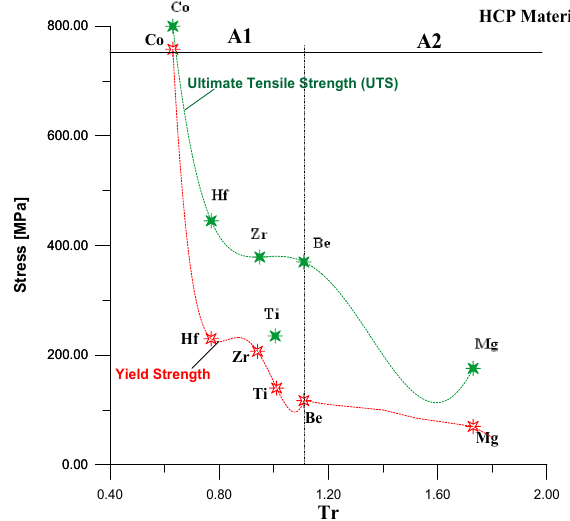
Figure 3. Relationship between yield stress and Tr for HCP metal.